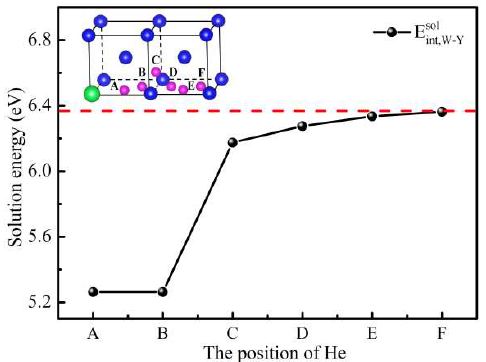
Table 2. The solution energy, binding energy, Bader charge, and distance from He to Y in the equi- librium W-Y system.